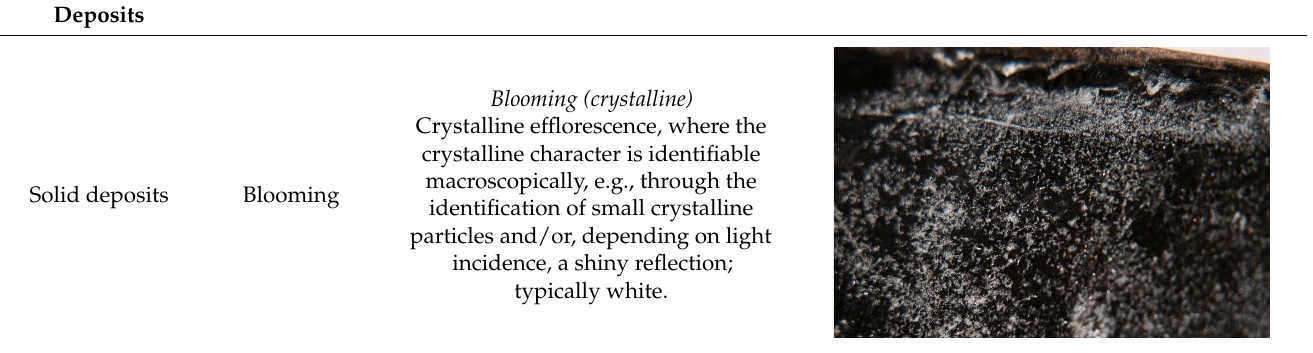
Table 2. Definitions of the category ‘deposits’.